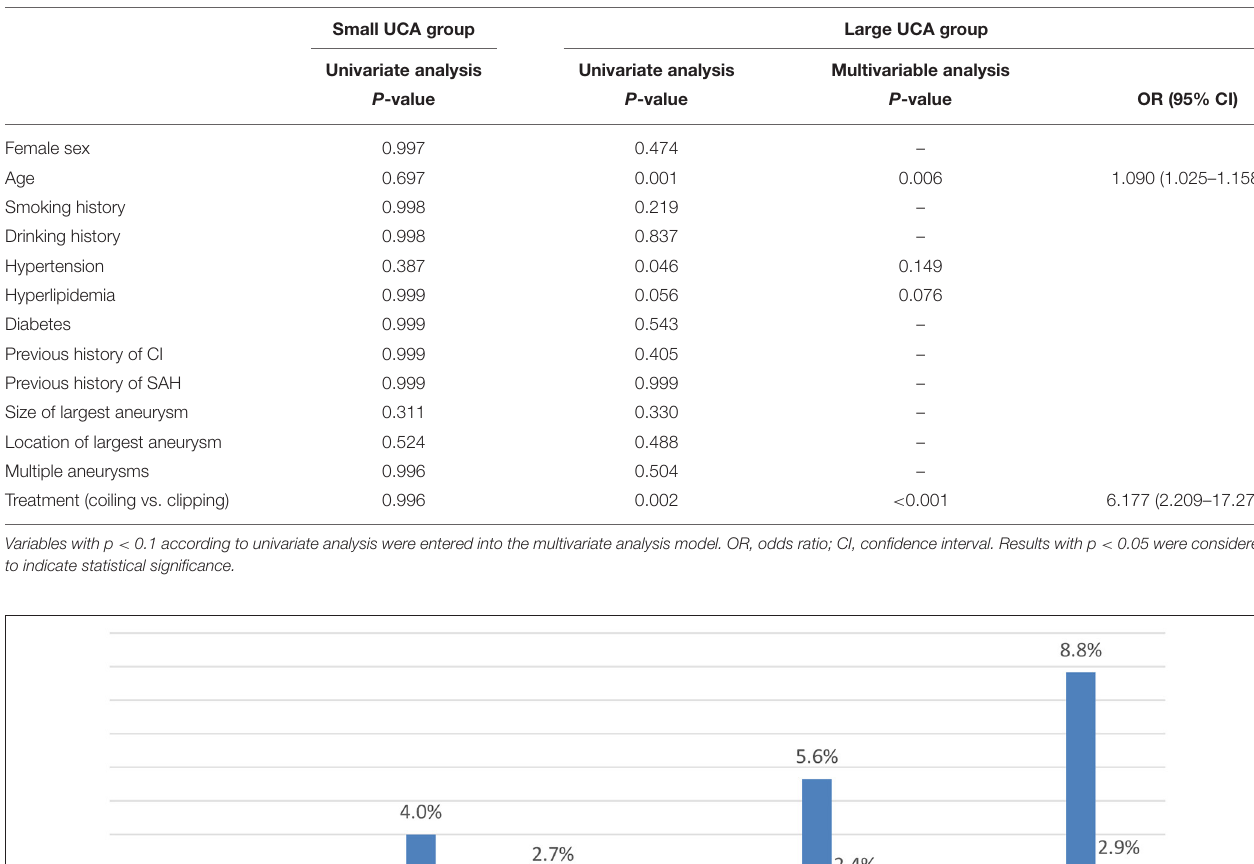
TABLE 4 | Risk factors associated with poor outcome in patients with UCAs.